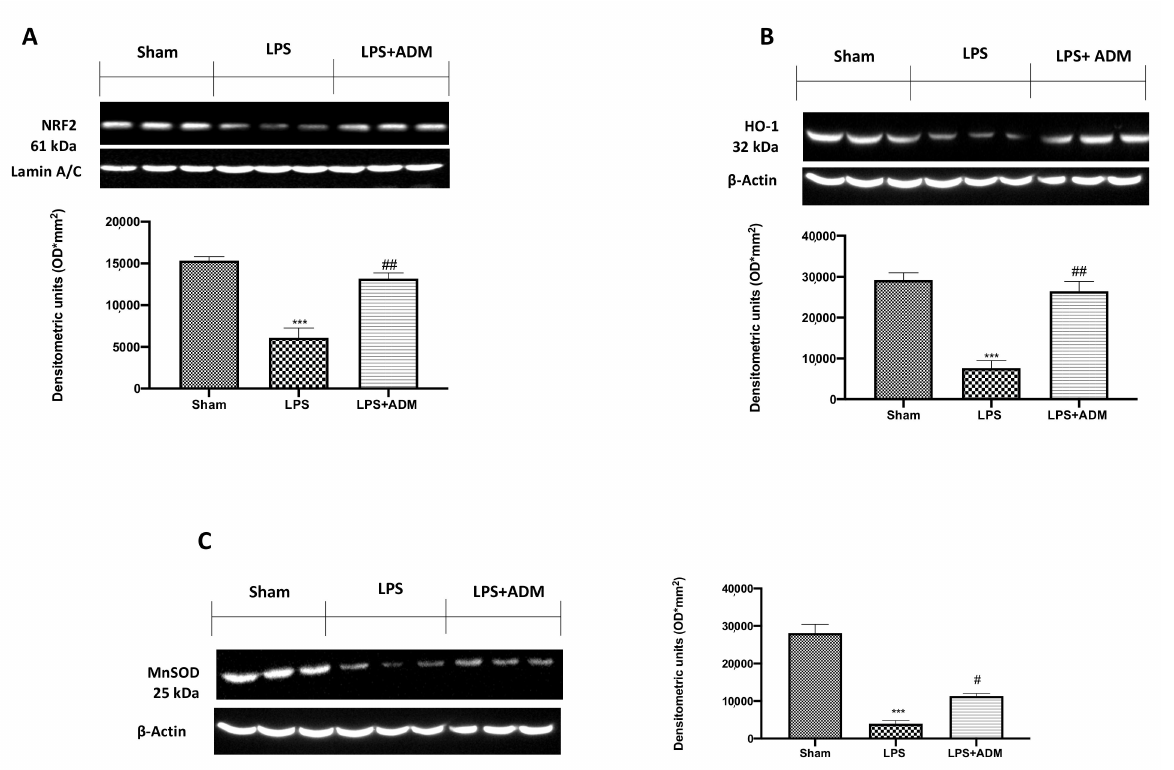
Figure 7. Western blot analysis for: Nrf2 ( A ); HO-1 ( B ); MnSOD ( C ). A demonstrative blot of lysates with a densitometric analysis for all animals is shown. Data are expressed as the mean ± SEM of N = 6 mice/group. *** p < 0.001 vs. sham; # p < 0.05 vs. LPS; ## p < 0.01 vs.